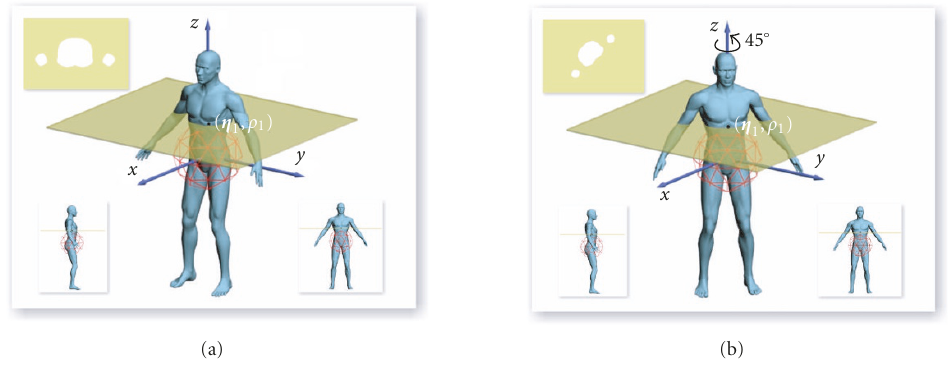
Figure 3: Rotation of f ( x ) rotates (cid:5) f ( i , j ) (upper left image) without causing a rotation of the point ( η